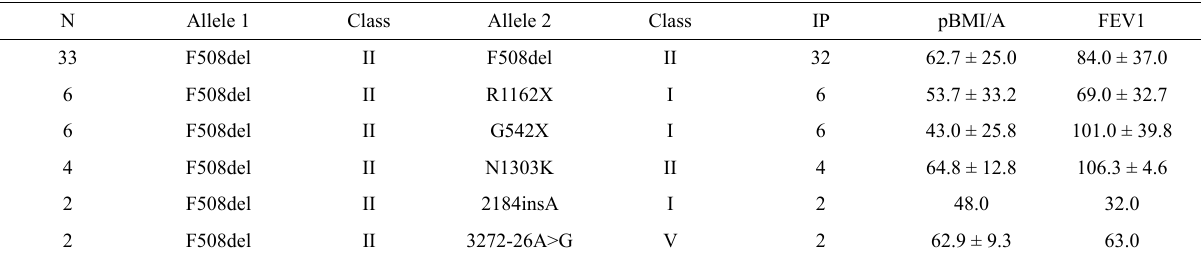
Table 4 – Candidate patients for the use of specific-causing variant drugs. Drug